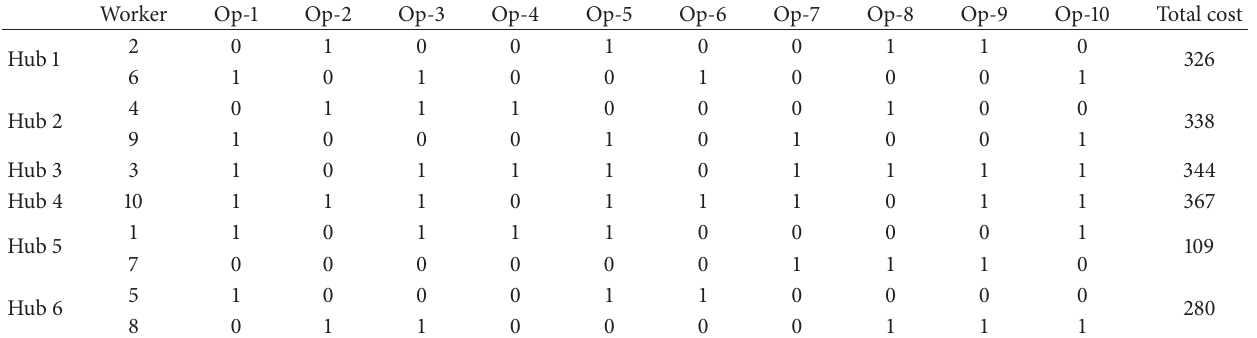
Table 10: All feasible operation-to-worker training